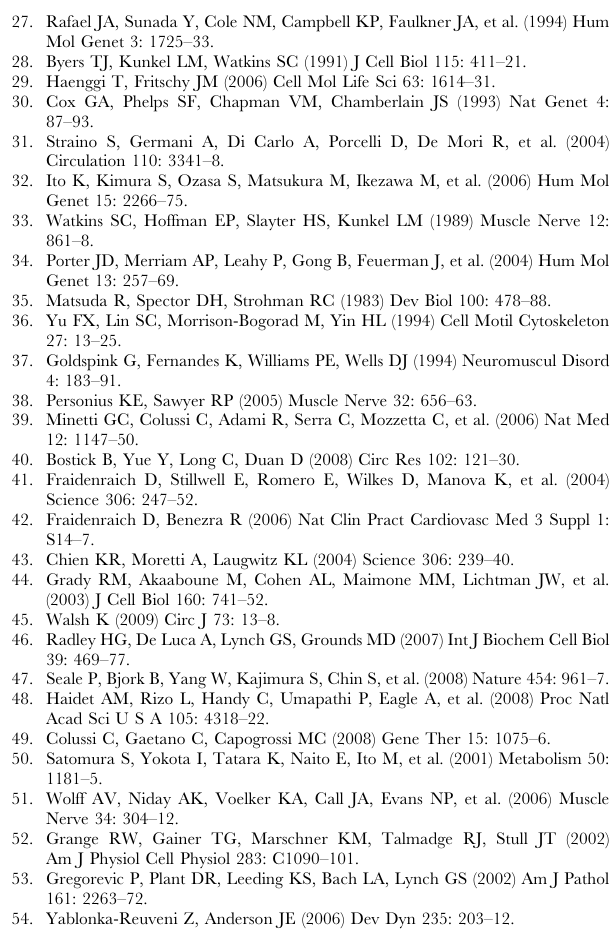
Table S3 Comparison of gene expression profiles between 4 month-old mdx and WT adipose tissues